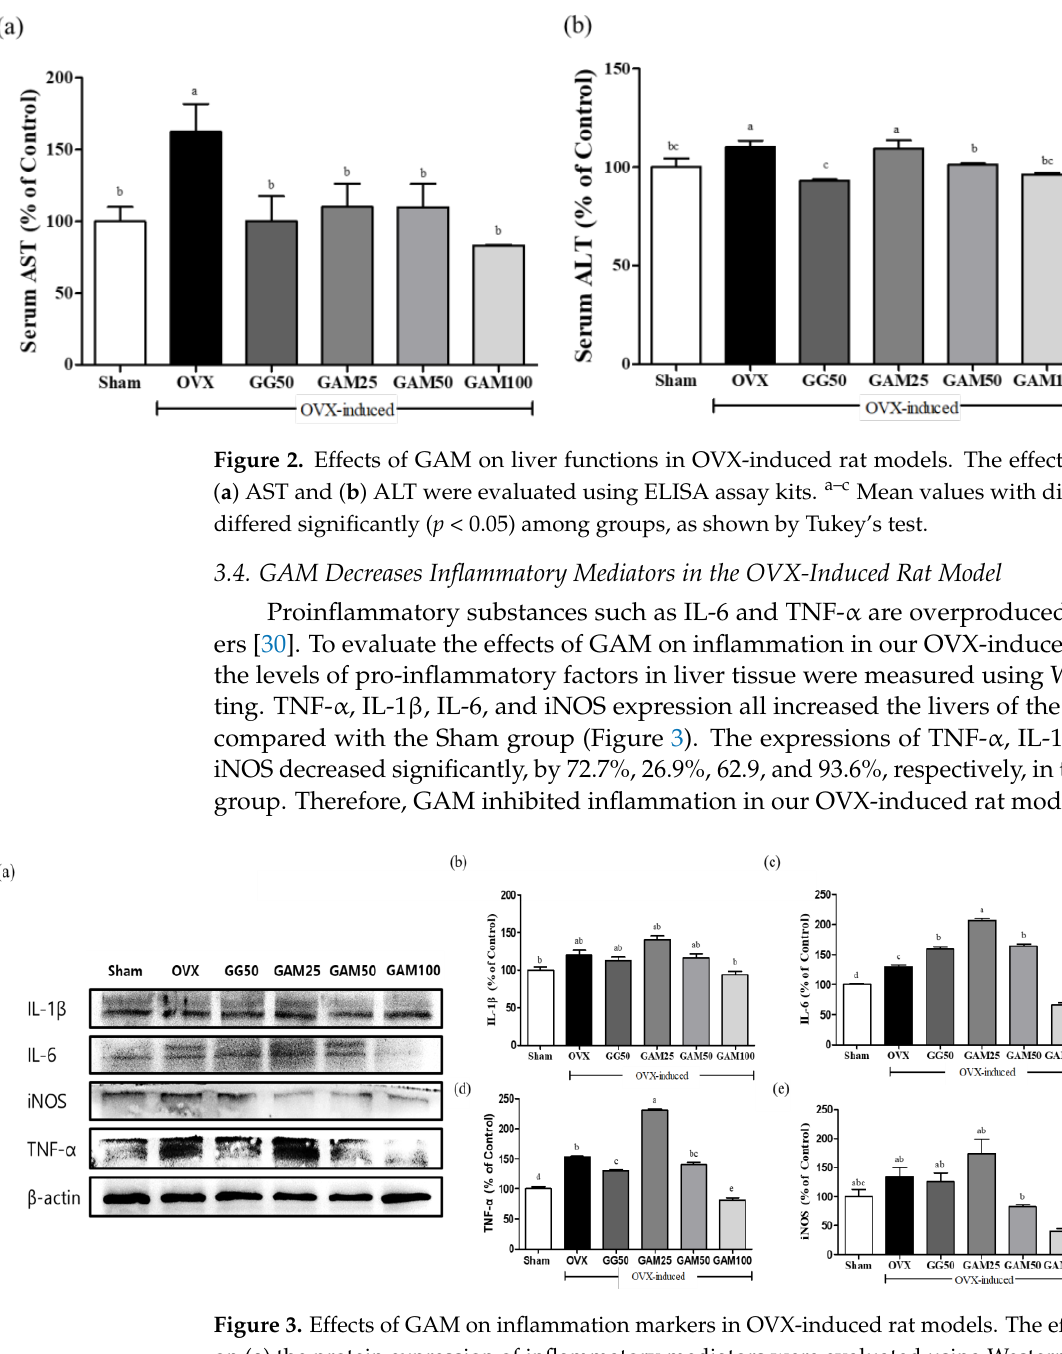
Figure 3. Effects of GAM on inflammation markers in OVX-induced rat models. The effects of GAM on ( a ) the protein expression of inflammatory mediators were evaluated using Western blot analysis and the levels of ( b ) IL-1β, ( c ) IL-6, ( d ) TNF-α, and ( e ) iNOS. a–e Mean values with different letters differed significantly ( p < 0.05) among groups, as shown by Tukey’s test.